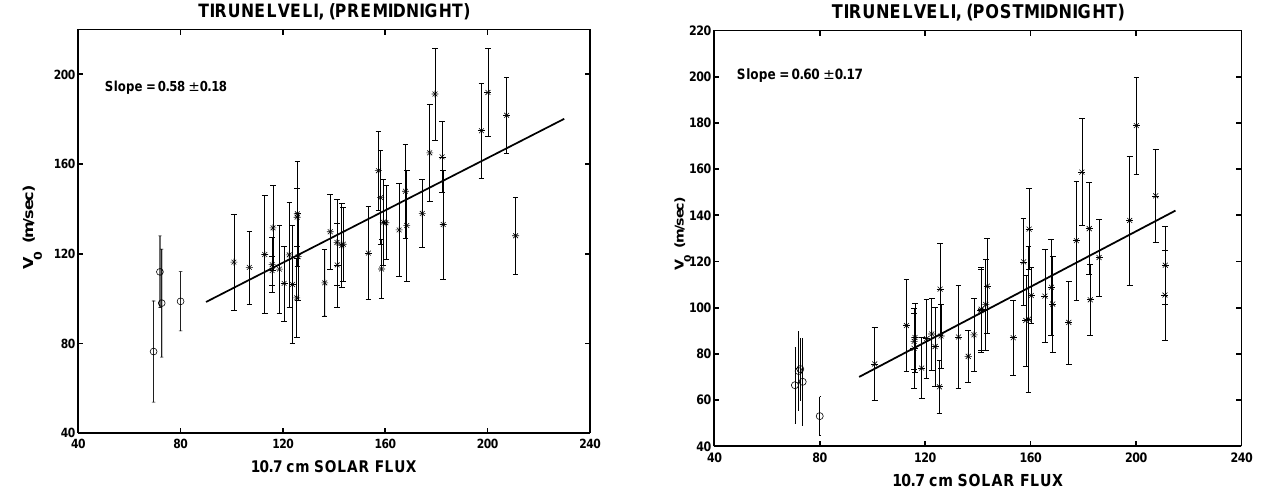
Fig. 9. plot of average V 0 , for post-midnight hours versus monthly average 10.7-cm solar flux (in units of 10 − 22 Wm − 2 Hz − 1